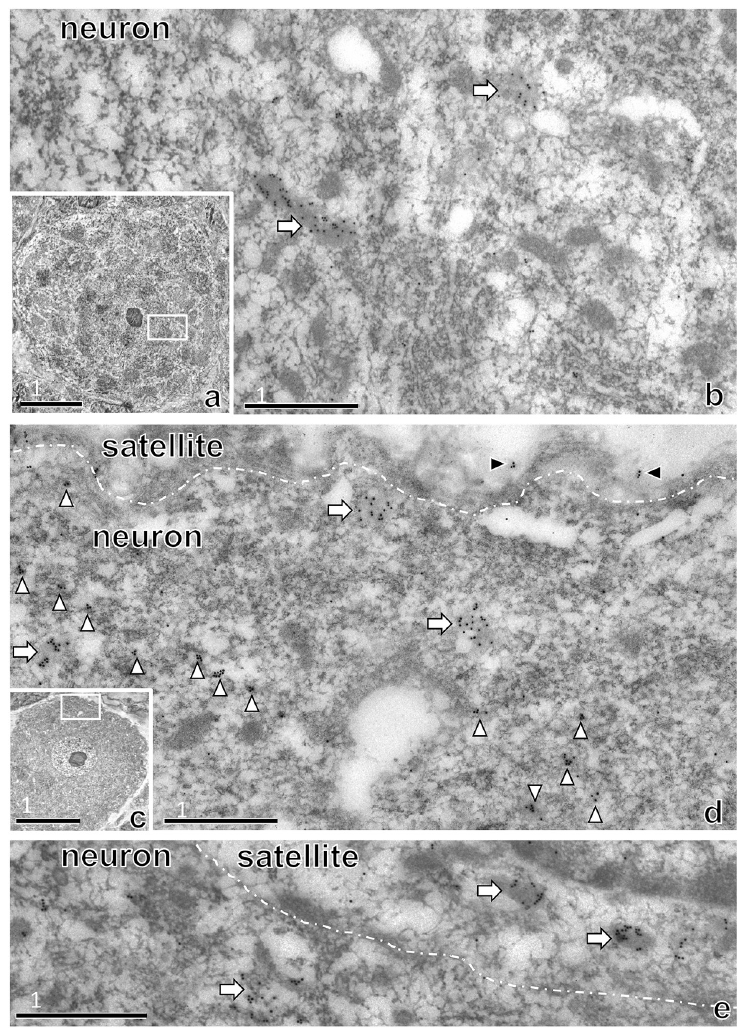
Fig 4. Immunoelectron micrographs of the DRG of rats at 8 weeks after birth stained with anti-saposin D antibody, which also reacts with PSAP. Many immunogold particles (15 nm) were observed in lysosome-like structures in larger neurons (a, b). In smaller neurons (c, d), immunogold particles were observed in many small lysosomes (white arrowheads) and the basal lamina of satellite cells (black arrowheads in d) as well as larger lysosomes (arrows). Many immunogold particles were also observed in the lysosome-like structures of satellite cells (arrows in e). The numbers on the bars indicate the scale in μ m.